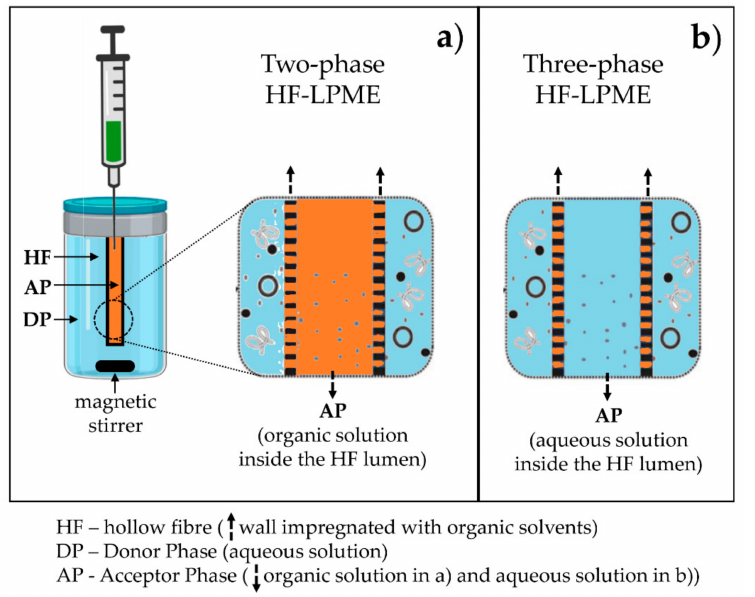
Figure 4. The representation scheme of the experimental HF-LPME system, with ( a ) two-phase and ( b ) three-phase HF-LPME systems (adapted from